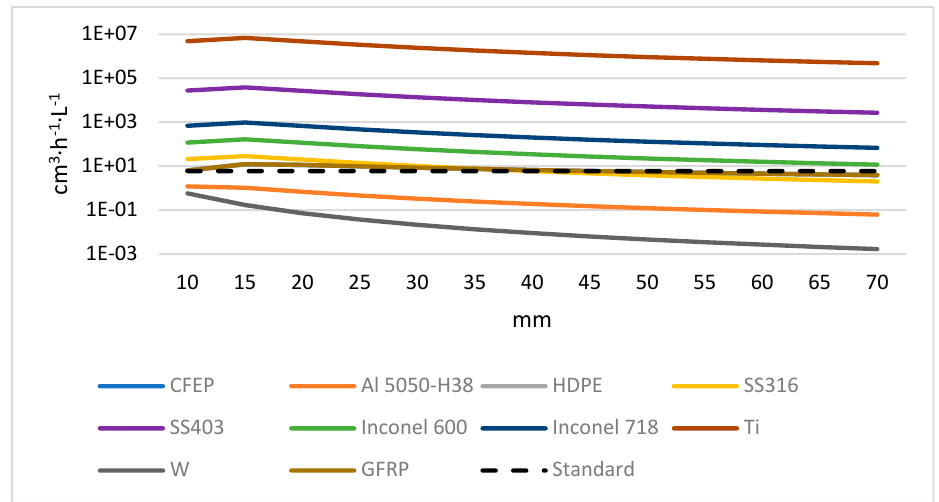
Figure 7. Flowrate of permeation for spheres made of several materials with ID from 10 mm and up to 70 mm, at 700 daN cm − 2 of inside pressure.